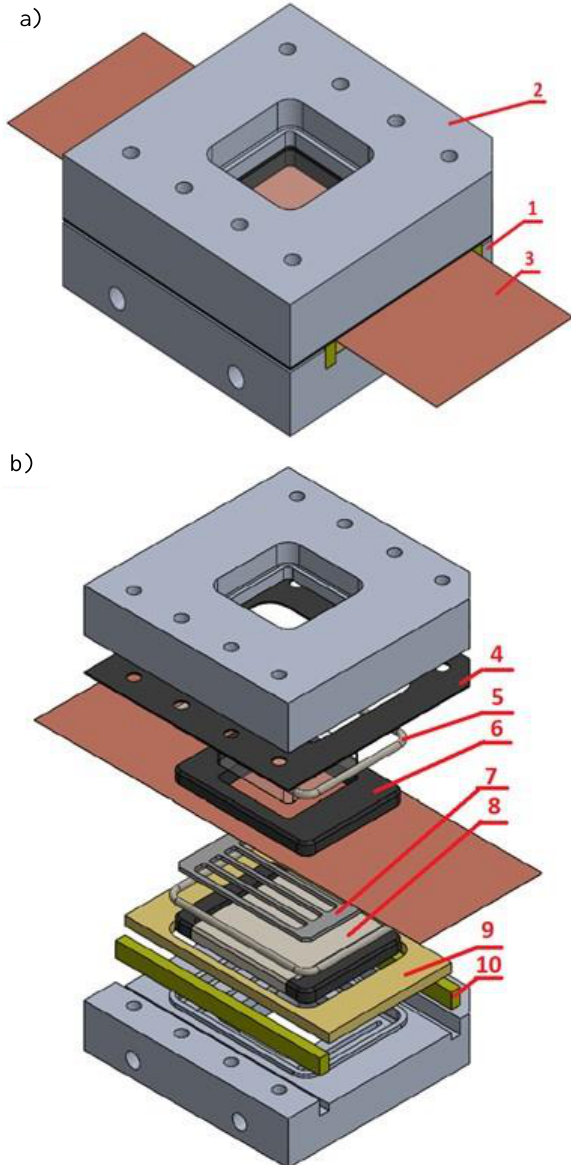
Fig. 5. An overall construction of the test section, 1 – upper body (a cover), 2 – bottom body half, 3 – heated foil, 4 – thin top insulation plate, 5 – top O-ring, 6 – thick insulation plate, 7 – minichannel plate, 8 – glass plate, 9 – bottom insulation, 10 – bottom insulation wedges.